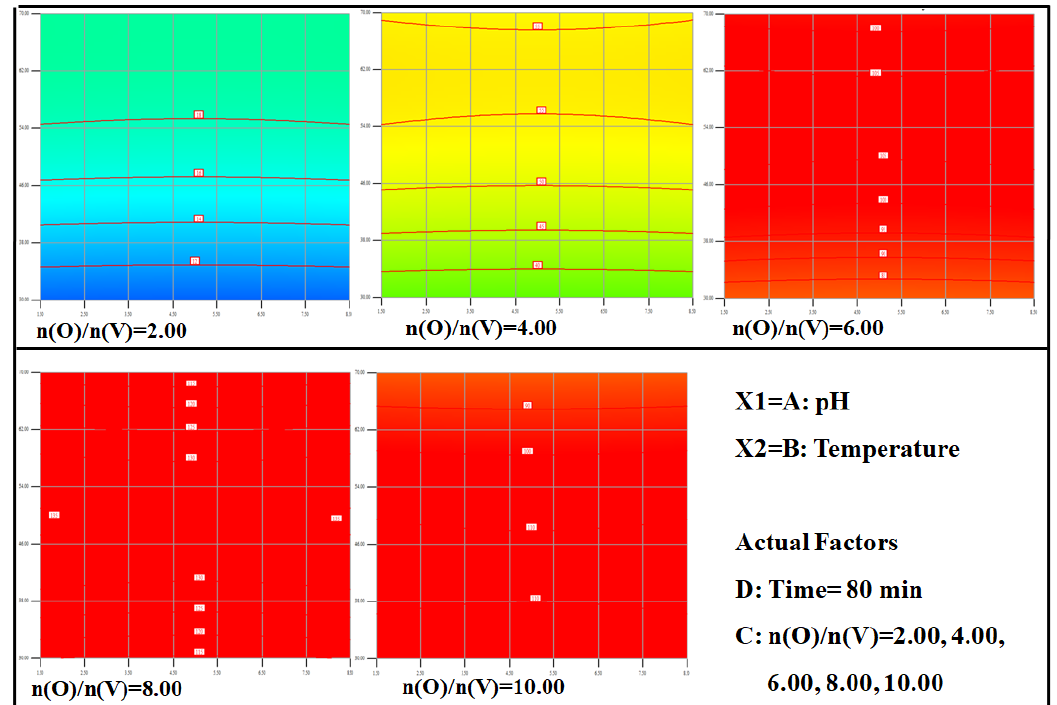
Figure 6. Response surface plots for factors (A to B).